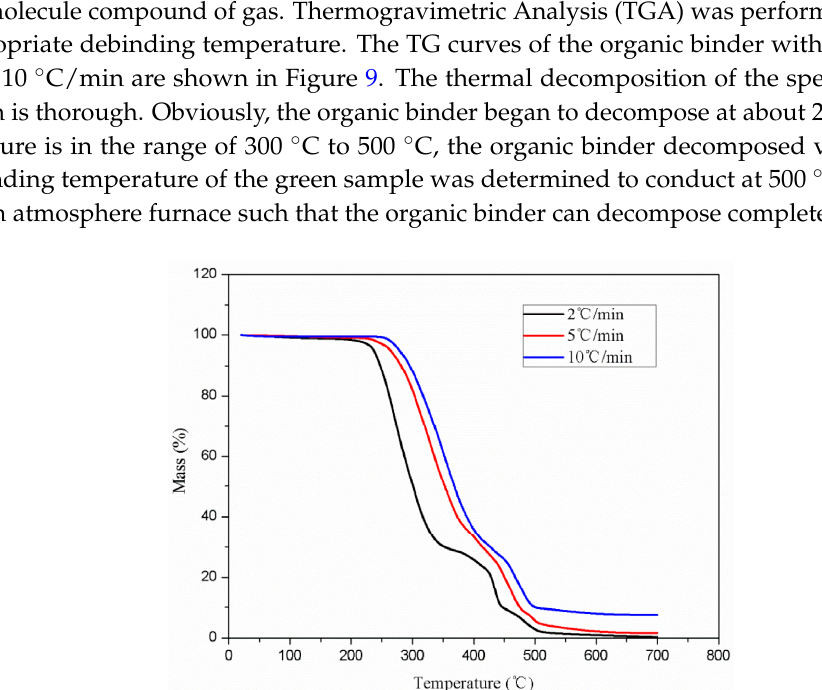
Figure 9. Thermogravimetric Analysis (TGA) curves of the organic binder with heating rates of 2, 5, and 10 °C/min.